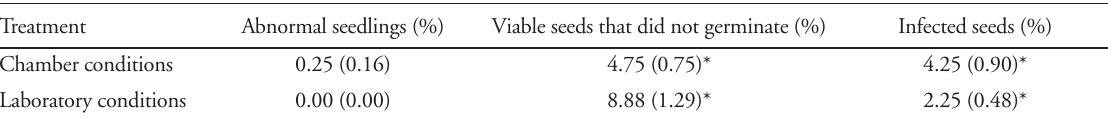
Table 2. Percentage of abnormal seedlings, viable seeds that did not germinate and infected seeds. Values represent an average of 8 replicates from 100 seeds in each experiment and their standard error in parenthesis. * = significant differences (p <0.05, t-test). Treatment Abnormal seedlings (%)